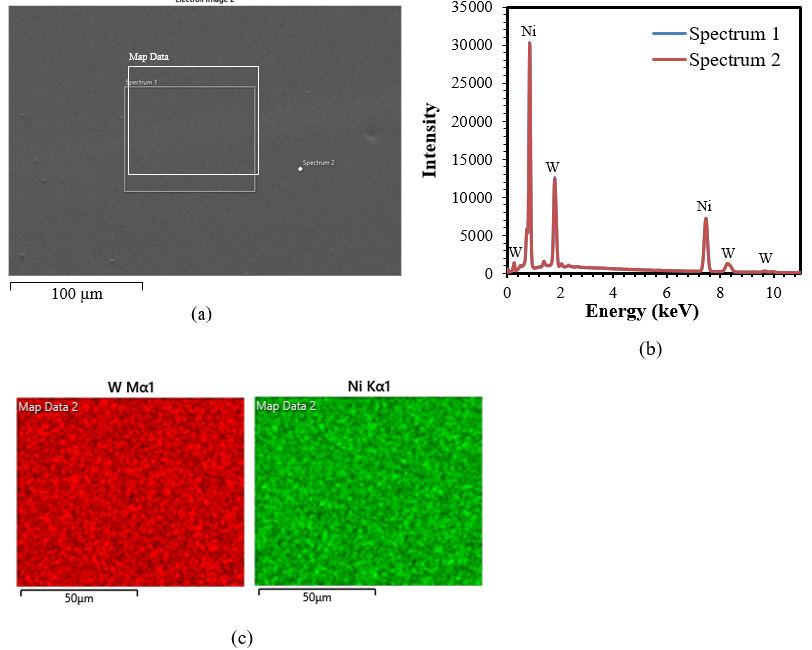
Figure 4. SEM micrograph ( a ), EDS spectra ( b ), and X-ray mapping ( c ) taken from the surface of the NiW coating; EDS spectra and EDS map of the area are highlighted with white rectangles in the SEM image.